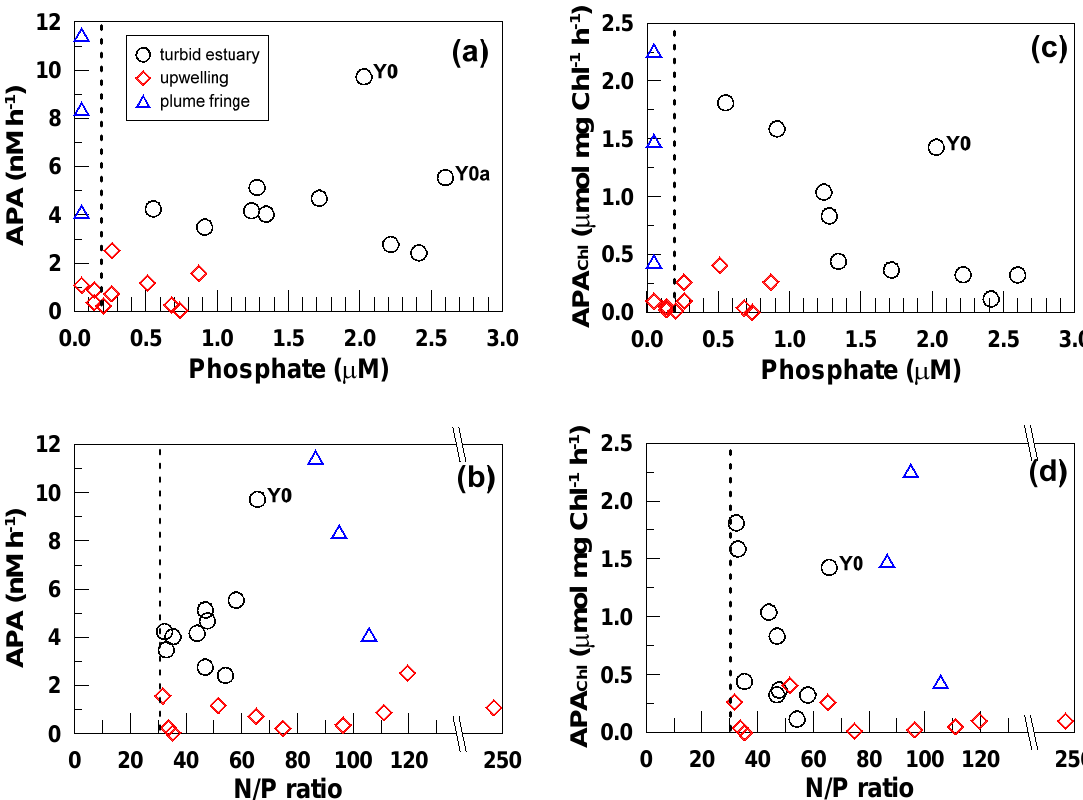
Fig. 7. Scatter plots for APA against phosphate (a) and N/P ratio (b) , and Chl- a -normalized APA (APA Chl ) against phosphate (c) and N/P ratio (d) for surface samples except the Qiantang estuary. The stations influenced by turbidity are represented by open circles. Red diamonds and blue triangles represent upwelling-influenced and plume fringe stations,